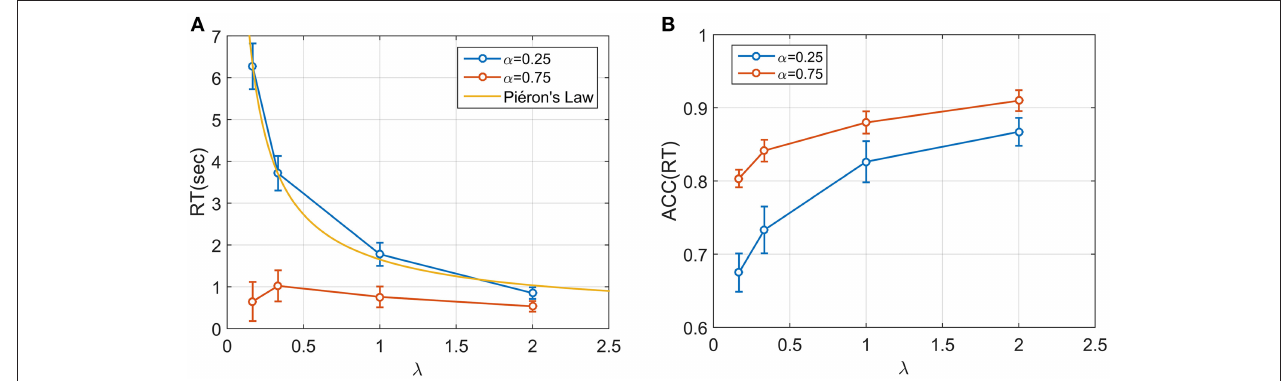
FIGURE 5 | (A) Median RT across the 20 participants for four speed conditions and two starting point conditions. A power (Piéron) function was fitted for the low starting point condition ( α 0.25 ). Median RT appear to be dependent both on λ and α and on their interaction. In particular, when α = monotonic with a peak at λ 0.33 . (B) ACC ( mdRT ) , showing how participant adjusted their positional response along the gauge based on both α and λ =